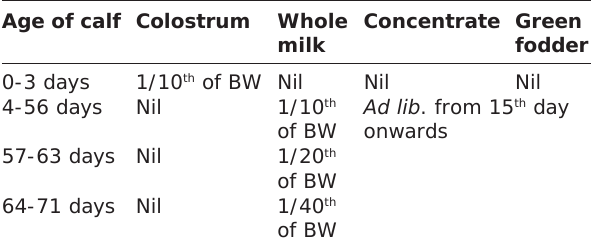
Table-1a: Feeding schedule of non-suckling (weaned) calves. Age of calf Colostrum